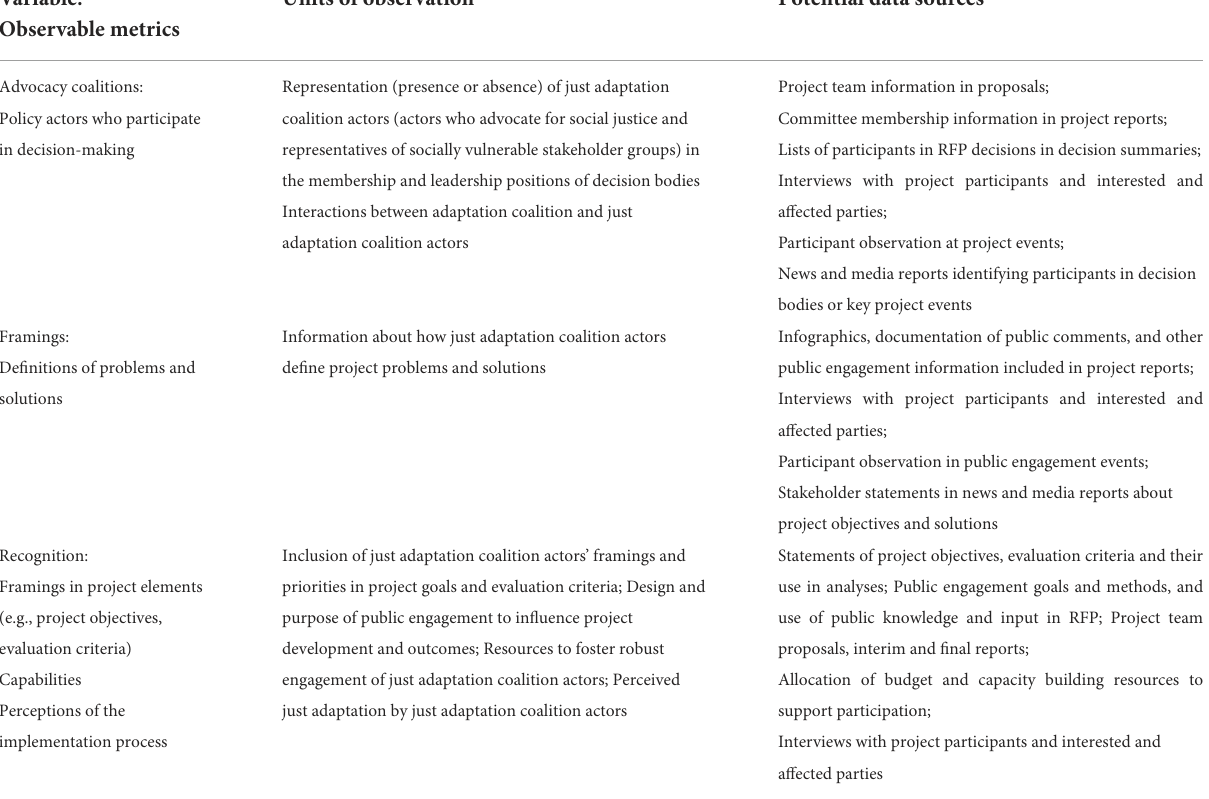
TABLE 1 Variables, observable metrics, units of observation, and potential data sources for just adaptation